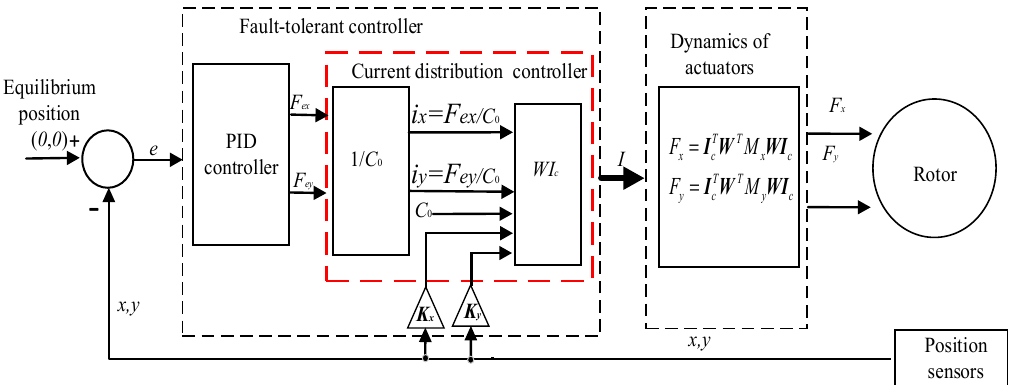
Figure 8. Fault-tolerant control strategy in magnetic bearings with redundant structures.